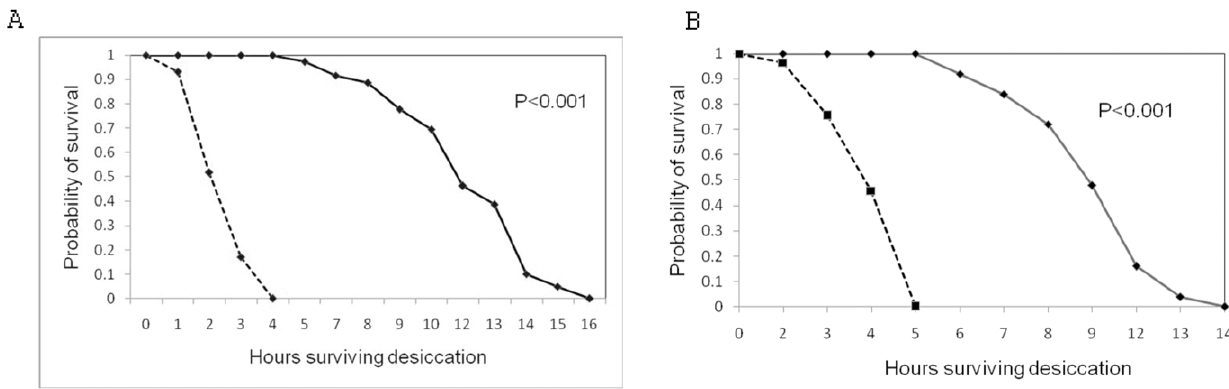
Figure 1. Survival curves for desiccation resistance in males (A) and females (B) derived from either protein (–) or carbohydrate (- - -) enriched medium.